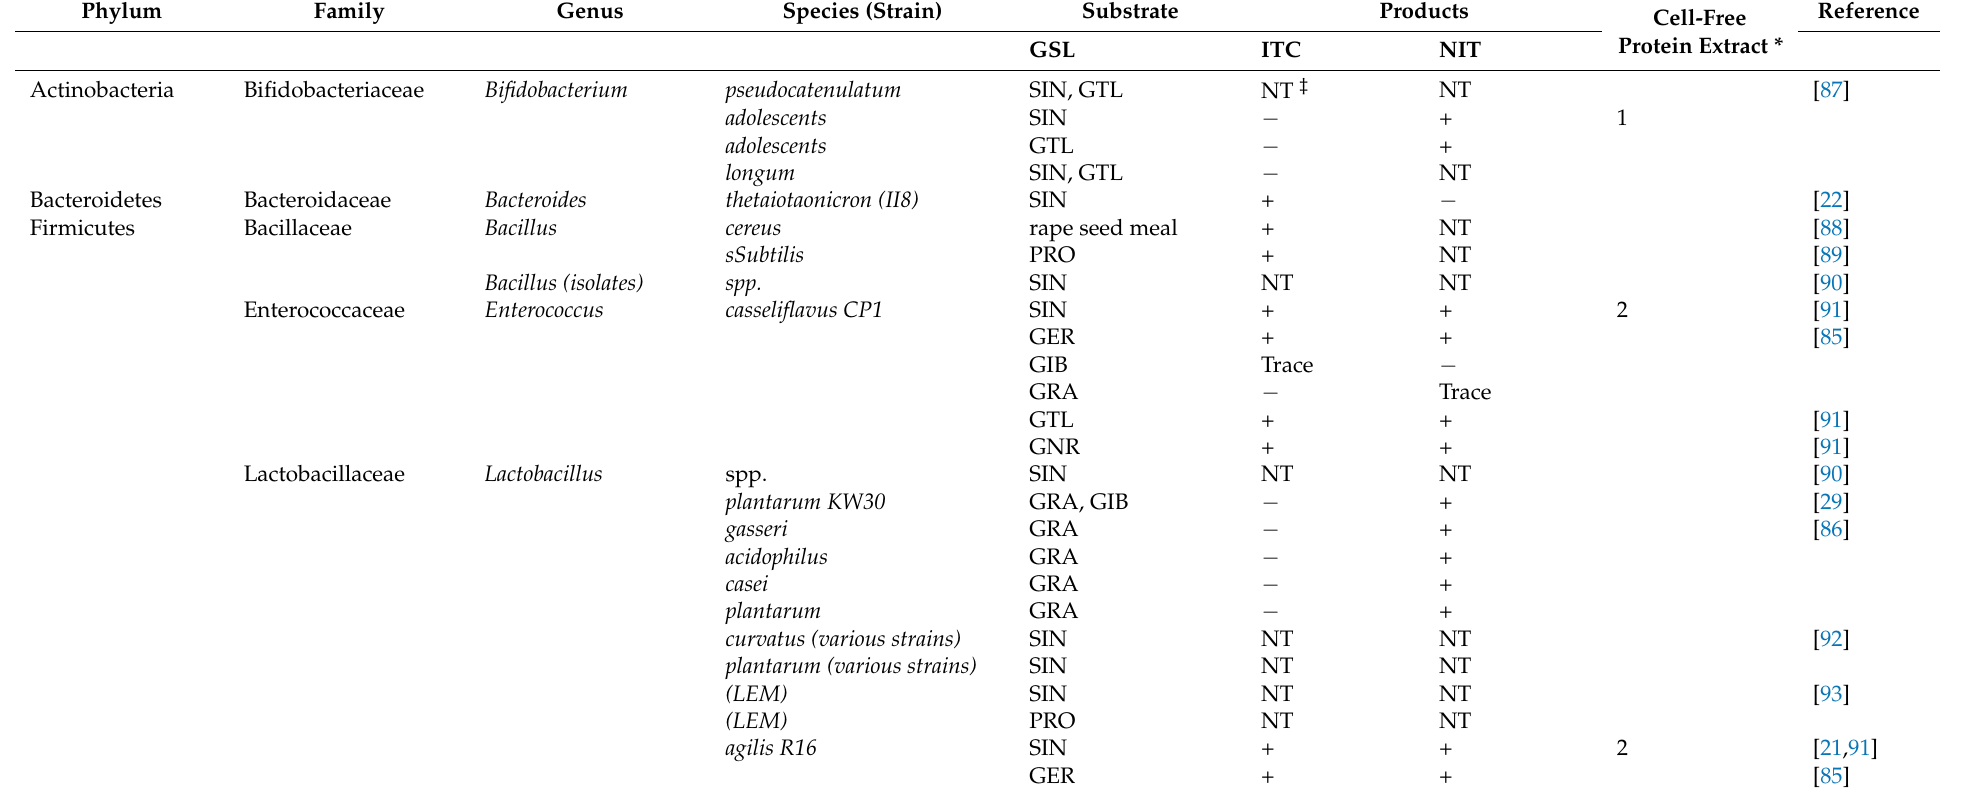
Table 2. Diversity of bacterial strains capable of in-vitro metabolism of GLS (modified from Narbad and Rositer 2018) [13]. Substrate abbreviations are reported according to the abbreviation used in Table